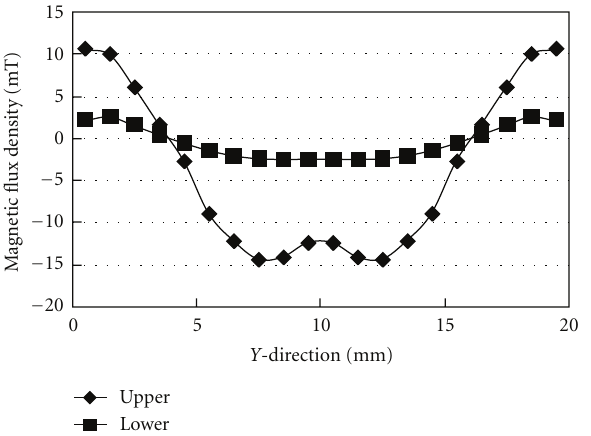
Figure 12: Magnetic field distribution of magnetic